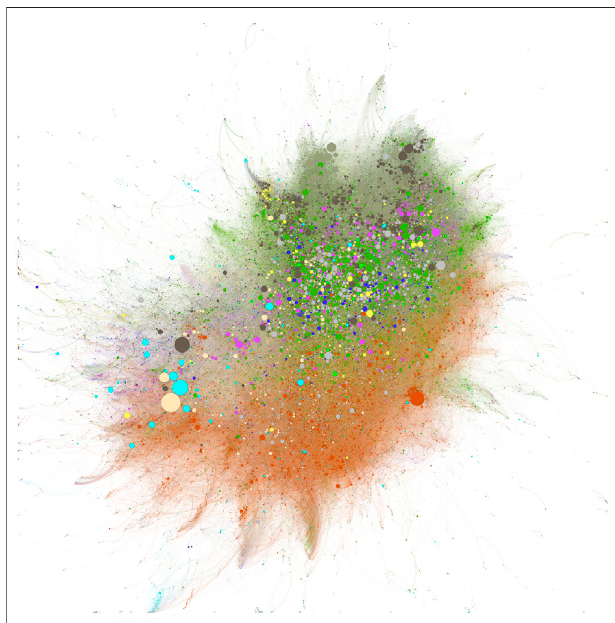
FIGURE 10 | Research Collaboration among COVID Researchers. Researchers colored by primary RCRC category. Clinical Research (green), Infectious Diseases (orange), Cancer (dark brown), Genetics (light brown), Cardiovascular (olive), Lung (dark blue), Digestive Diseases (purple), Neurosciences(yellow), andBioengineering(lightblue).Clusteringisbasedon proximityofco-authorship.Nodesizeisdeterminedbynumberofpublications in whole research career.